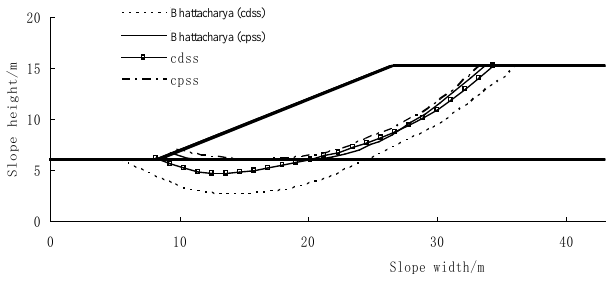
Figure 12. Summary of critical slip surfaces for example 2.